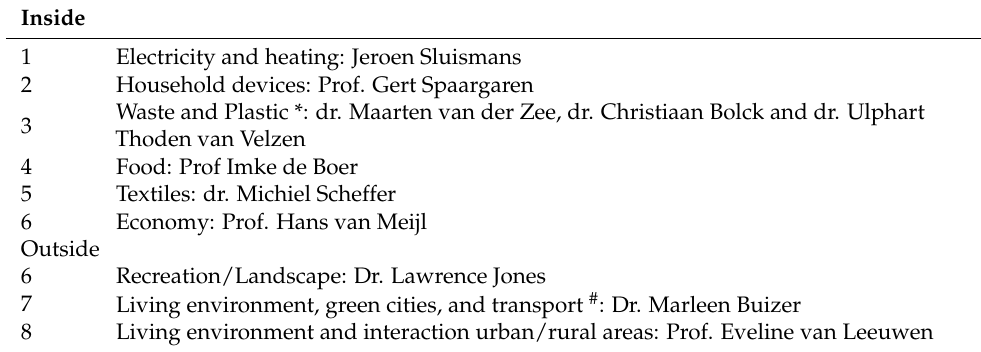
Table 1. Elements of the circular household and interviewed